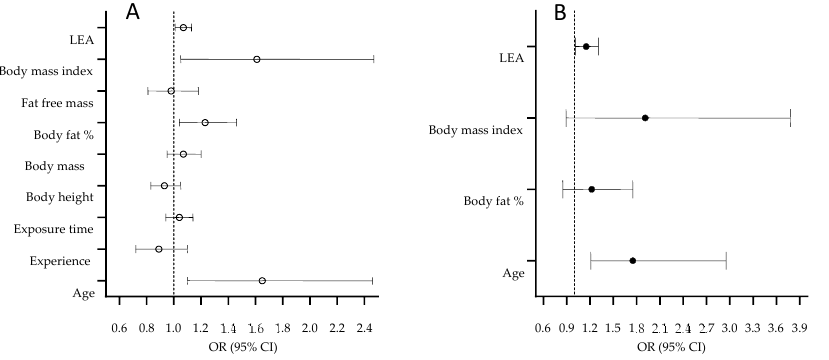
Figure 1. Univariate ( A ), and multivariate ( B ) correlates of soft-tissue injury in contemporary dance. The univariate logistic regression calculated between the study variables and the oc- currence of soft-tissue injury evidenced a higher risk for injury in older dancers (OR = 1.46, 95%CI: 1.10–2.46), those with higher BF% (OR = 1.23, 1.04–1.46), higher BMI (OR = 1.61, 95%CI: 1.05–2.47), and a lower EAS (OR = 0.81, 95%CI: 0.65–0.91) (Figure 1A). The multi- variate regression model, which included all significant univariate predictors in a predic- tor set of variables, highlighted the dancers’ age (OR = 1.75, 95%CI: 1.21–2.95) and EAS (OR = 0.84, 95%CI: 0.71–0.95) as significant predictors of soft-tissue injury (Figure 1B), with appropriate model fit (HL = 0.57, p = 0.87).